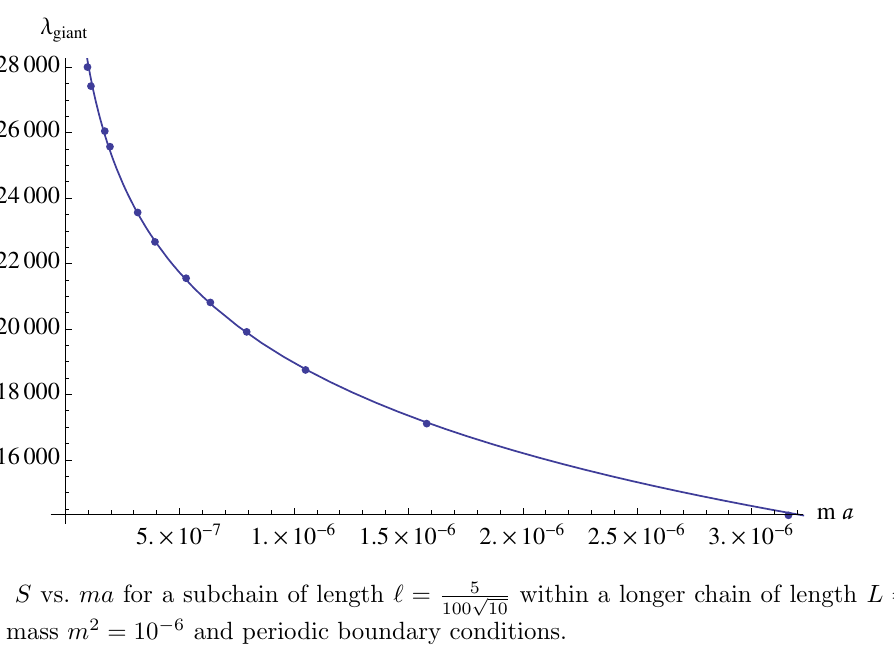
Figure 5 . S vs. ma for a subchain of length ‘ = 5 with (cid:12)xed mass m 2 = 10 (cid:0) 6 and periodic boundary